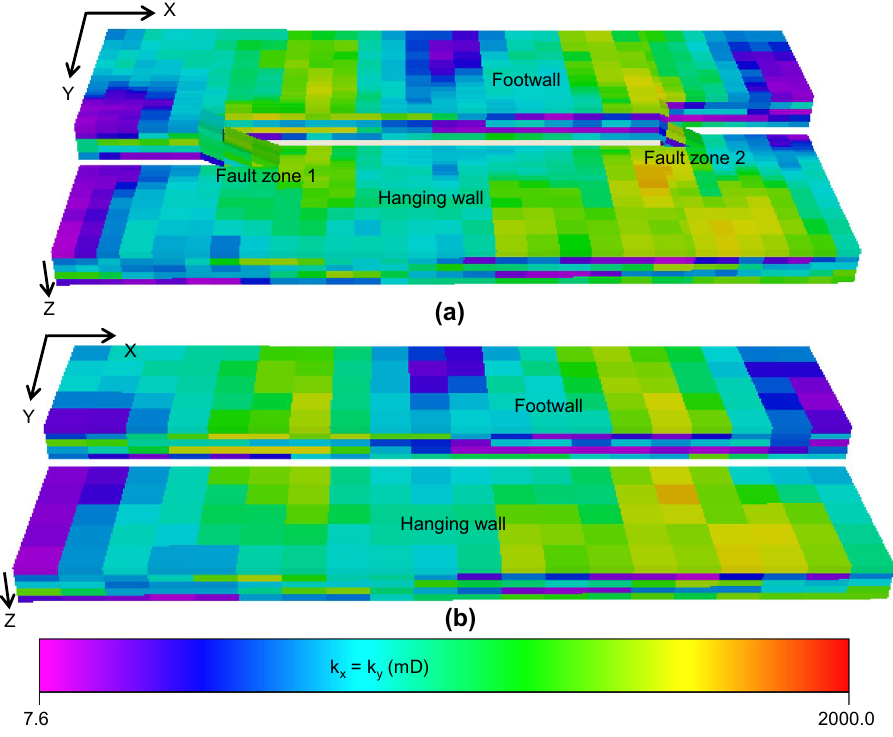
Figure 2. Reservoir models (color bar represents horizontal permeability profile). ( a ) The truth model. ( b ) The upscaled